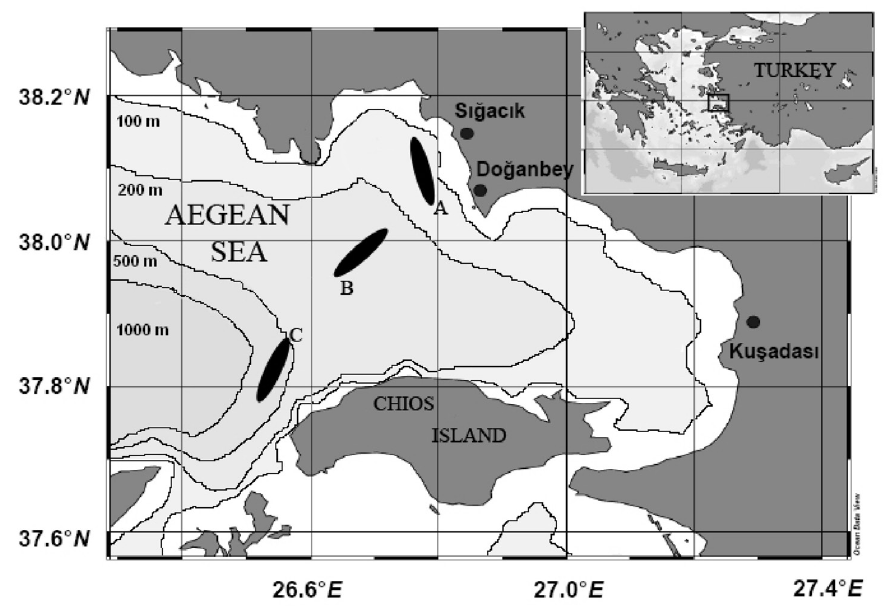
Fig. 1. – Sampling area (indicated by full trimmings; A150 m; B 350 m; C 550 m sampling